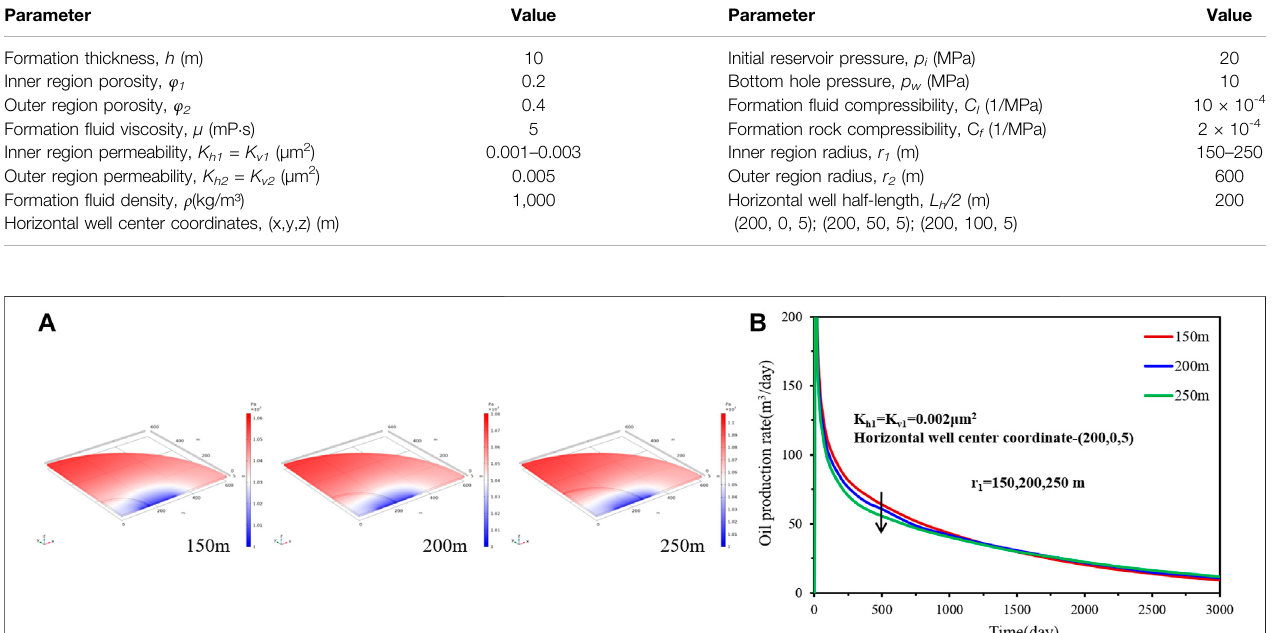
TABLE 3 | Input parameters for horizontal well passing through both inner region and outer region on single sides.